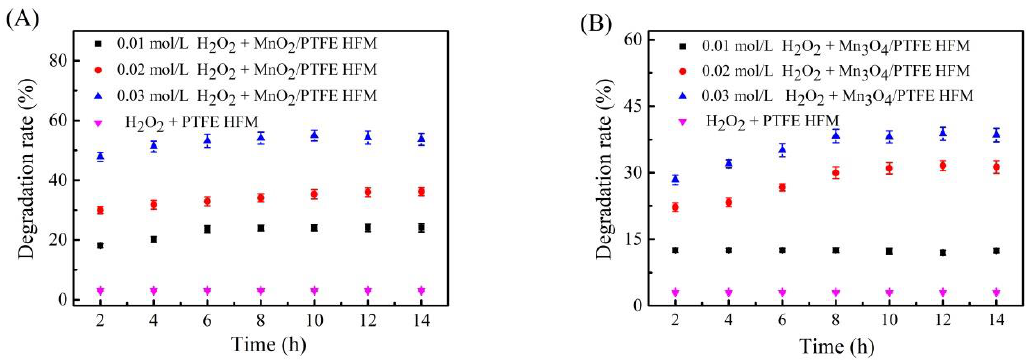
Figure 9. The influence of H 2 O 2 on the degradation rate of phenol: ( A ) MnO 2 /PTFE HFM; ( B ) Mn 3 O 4 /PTFE HFM.